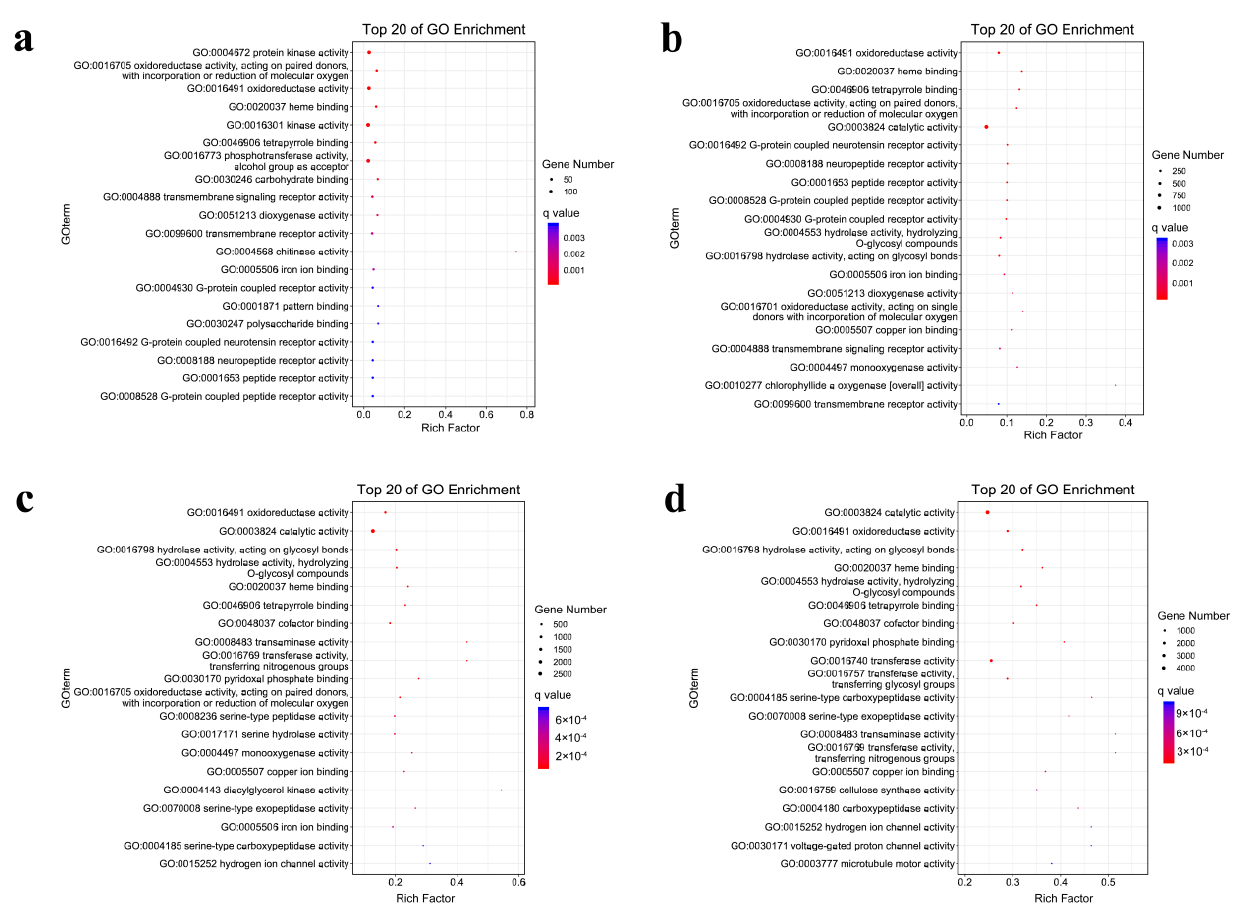
Figure 5. GO enrichment analysis of the DEGs in roots: ( a – d ) represent gene enrichments at 24 h, 48 h, 96 h and 144 h, respectively. DEGS, differentially expressed genes; GO, gene ontology.